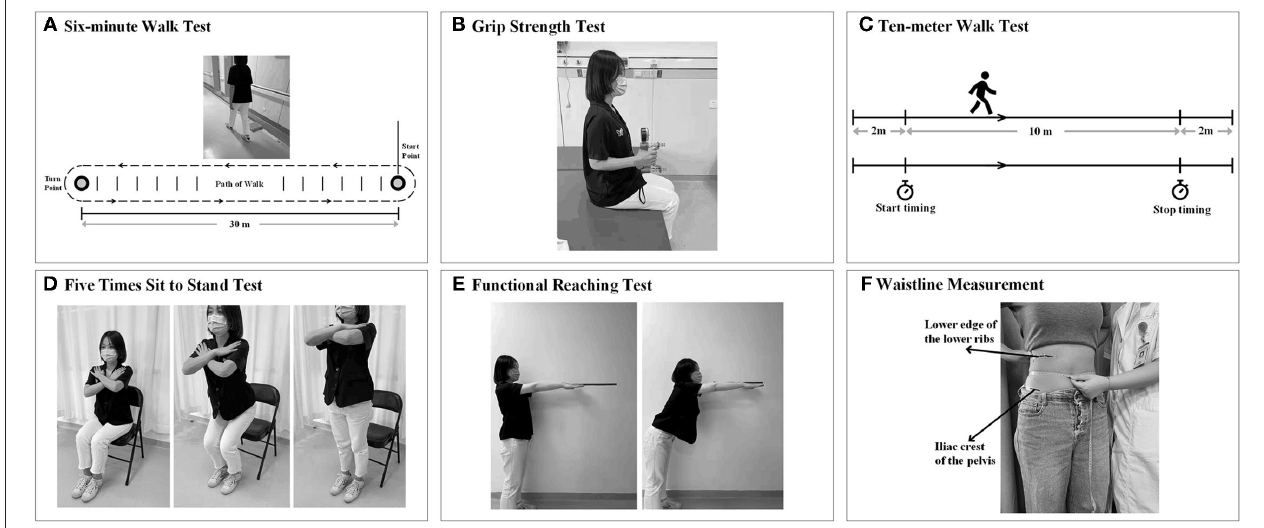
FIGURE 1 | Measurement of indicators related to cardiorespiratory fitness (CRF). (A) 6-min walk test (6MWT). (B) Grip strength (GS) test. (C) 10-m walk test (10 mWT). (D) The five-times sit-to-stand test. (E) Functional reaching test (FRT). (F) Waistline measurement (circumference at the middle of the lower edge of the lower ribs and the iliac crests of the pelvis).